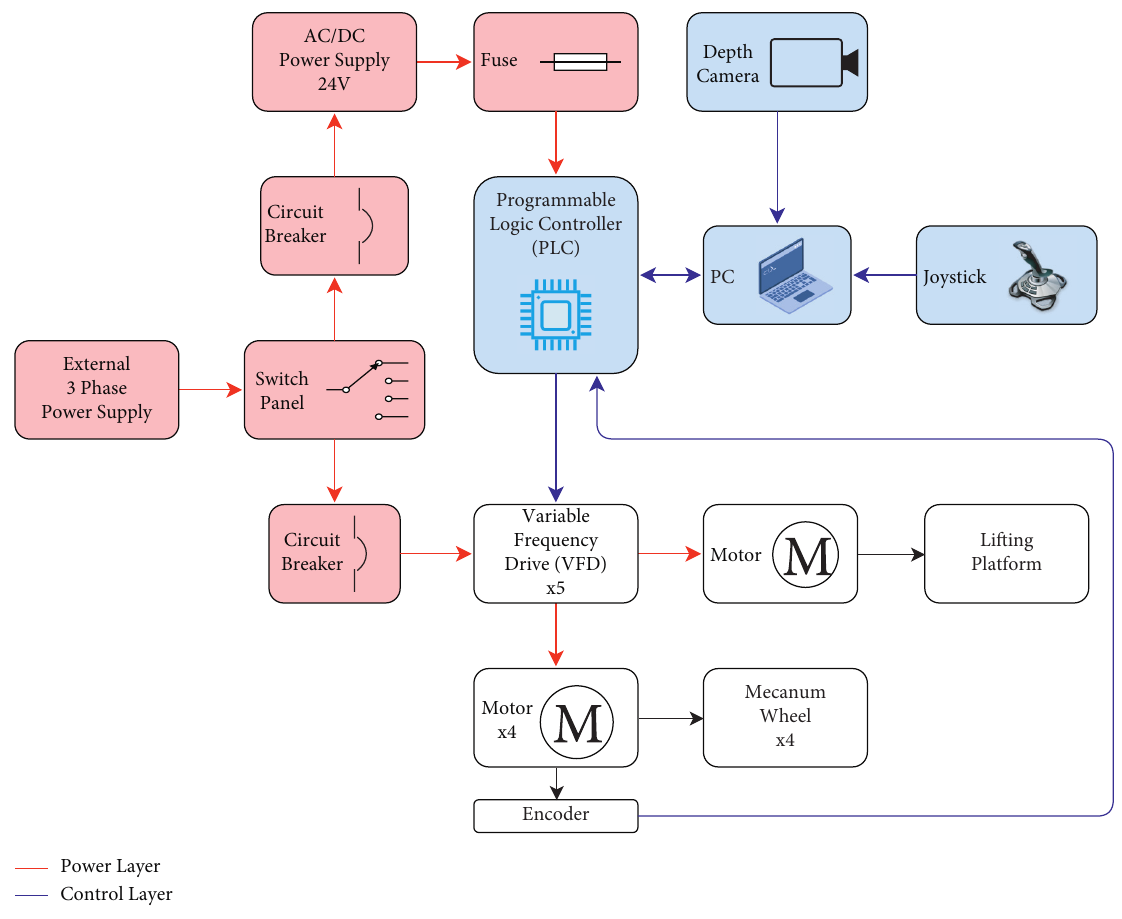
Figure 13: Block diagram of the overall vehicle.